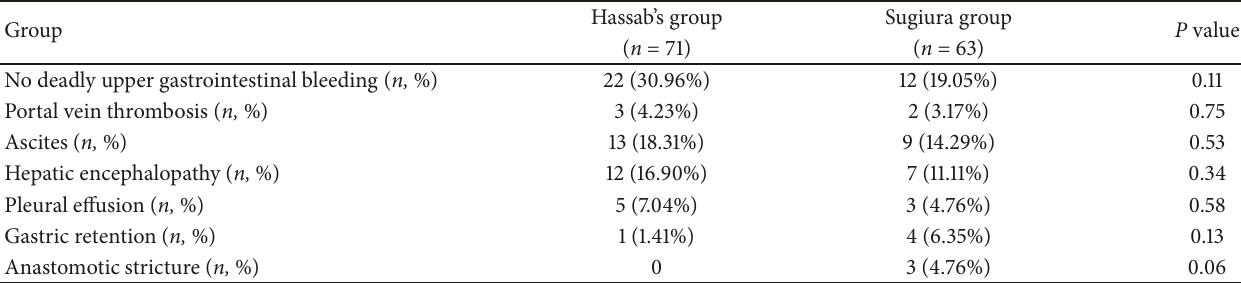
Table 4: Incidence of morbidity during